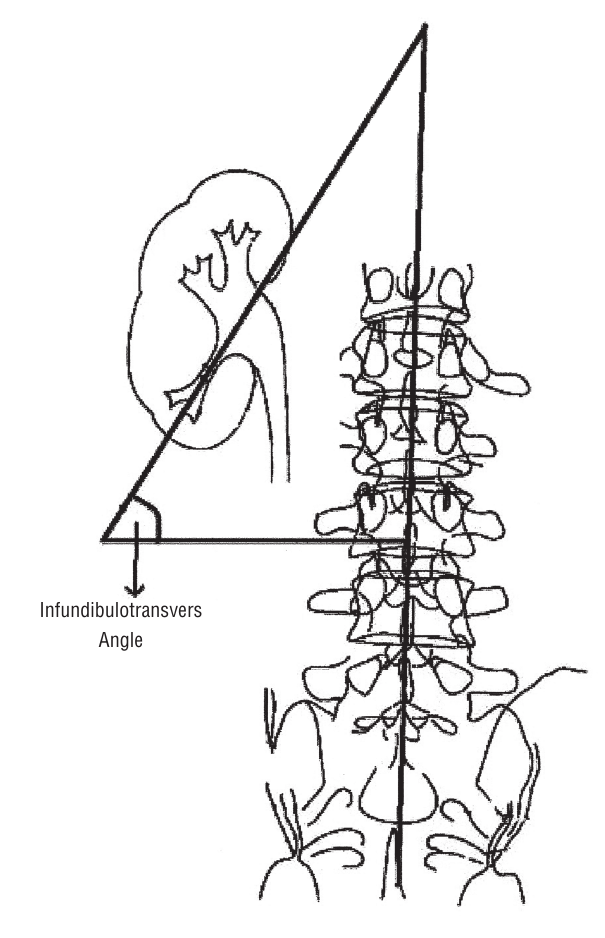
Figure 3 - Infundibulutransverse angle was described as the angle between the central axis of the lower pole infundibulum and a line which is obtained by drawing a perpendicular to midvertebral line (A line passing through the mid portions of vertebral bodies, connecting the